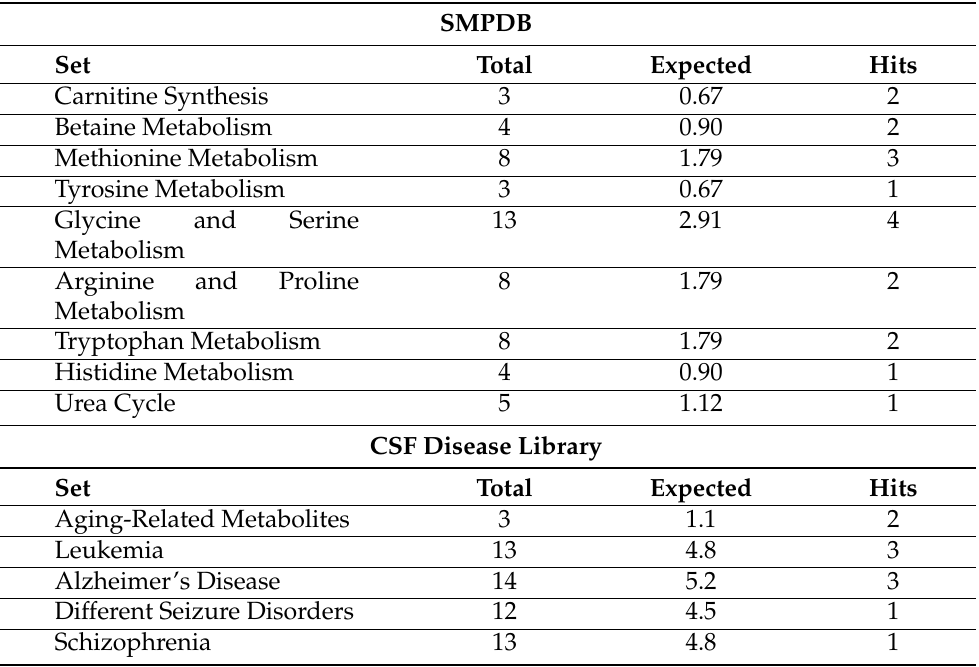
Table A2. Metabolite Set Enrichment Analysis: Output of MSEA on the targeted profile based on metabolites significant for PD classification in univariate logistic regression. Set are the pre-defined metabolite sets in the SMPDB (left) and CSF disease library (right). Total is the number of metabolites in these sets, hits is the number of metabolites shared between the pre-defined sets and our input list, and expected is the expected number of metabolites shared by random chance, using the cumulative hypergeometric